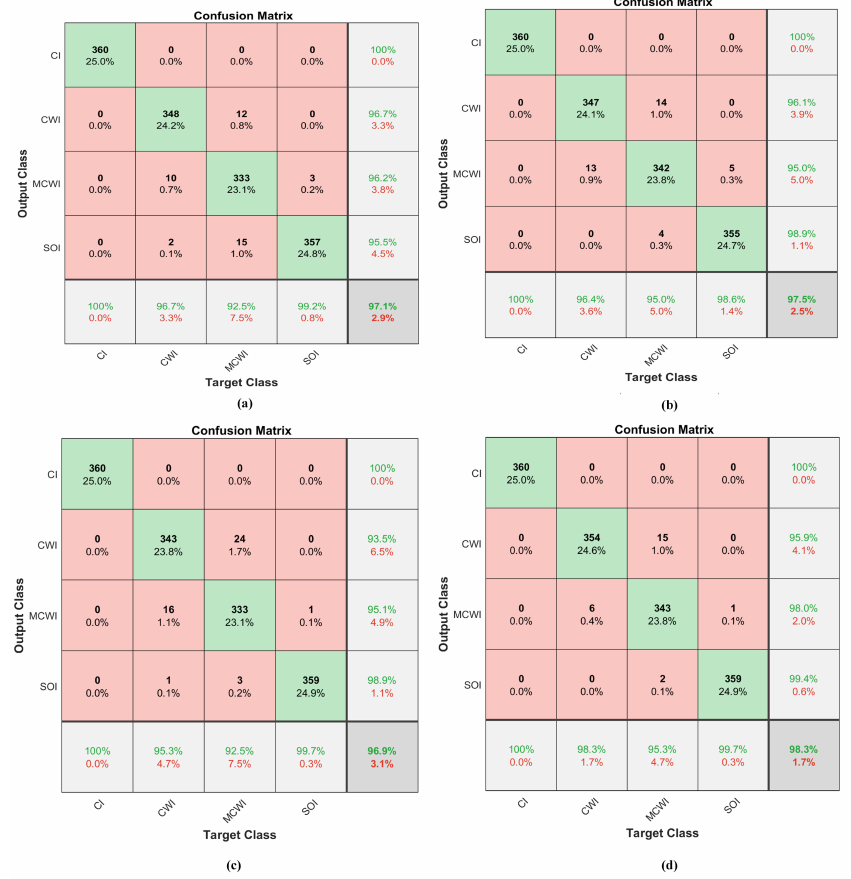
Figure 4. RFI classification phase results using ( a ) AlexNet (97.1%), ( b ) VGG16 (97.5%), ( c ) GoogleNet (96.9%), and ( d ) ResNet18